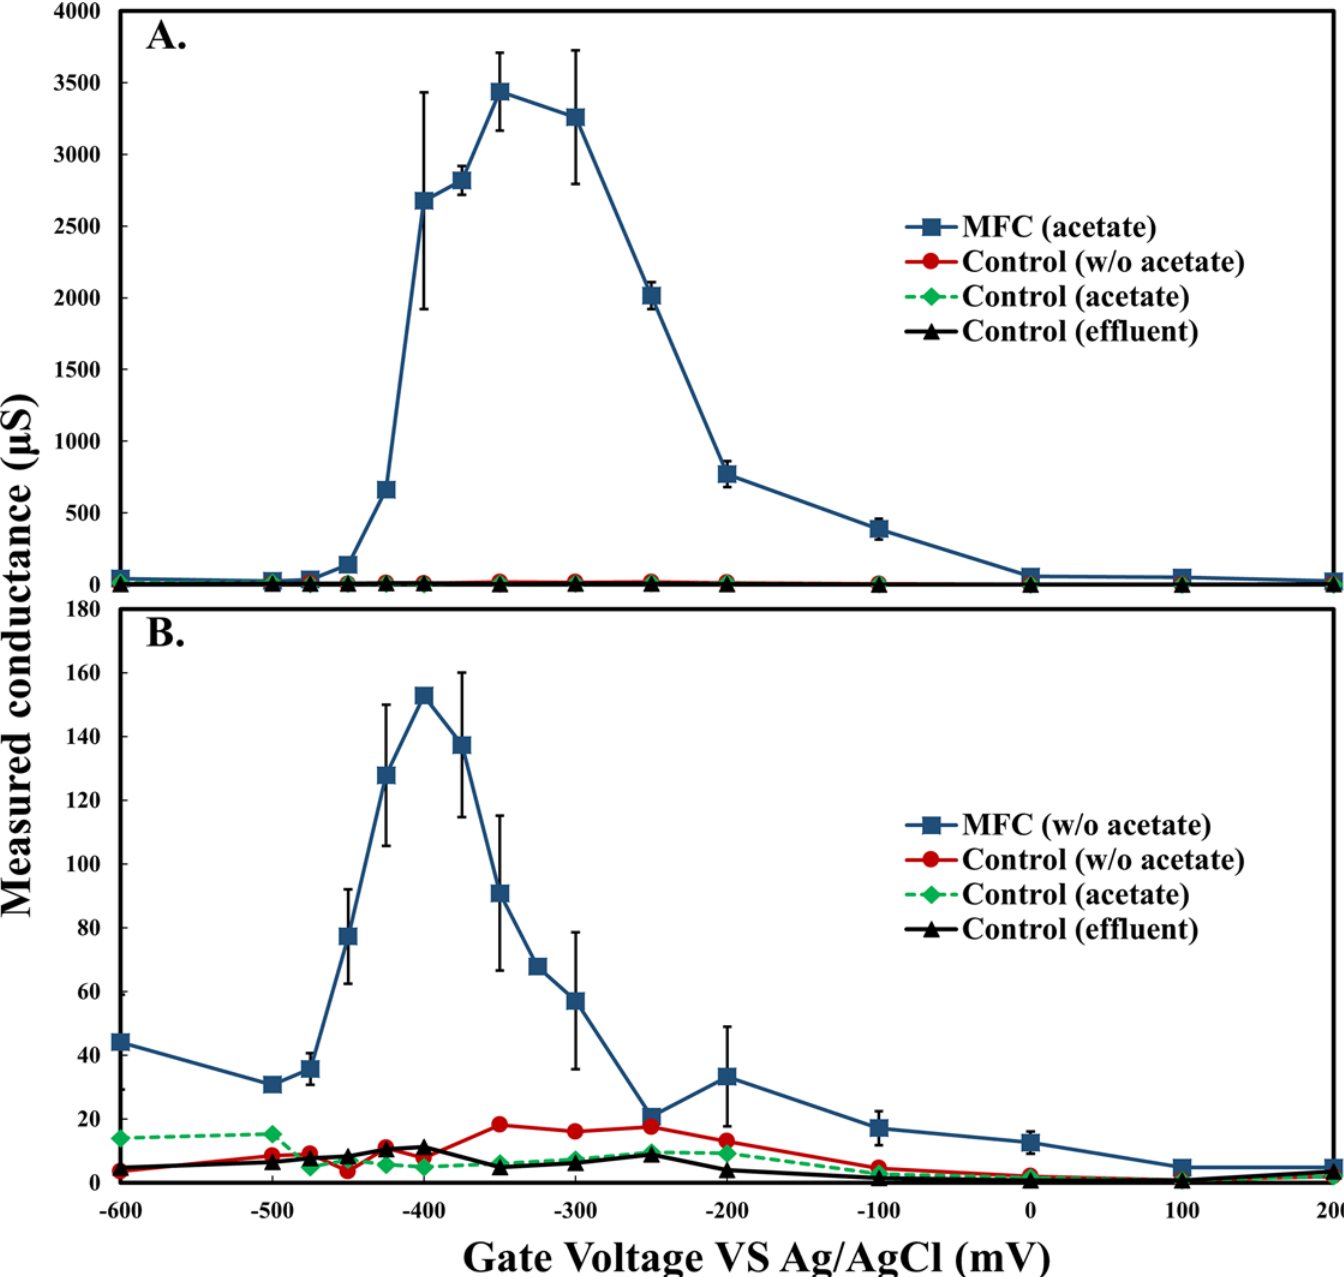
Fig 4. Conductivity of mixed species biofilms and control estimated by electrochemical gating analysis. Error bars represent standard deviation (n = 2). doi:10.1371/journal.pone.0155247.g004 PLOS ONE | DOI:10.1371/journal.pone.0155247 May 9,